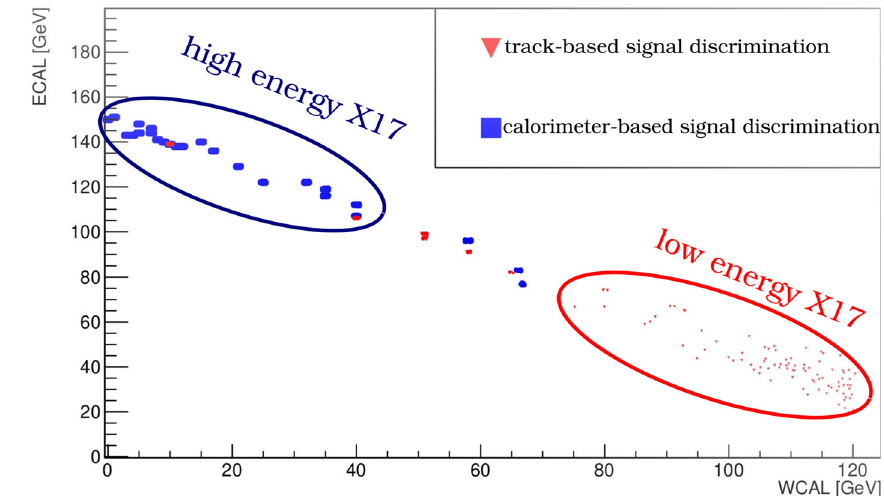
Table 1 N ne w / N old ratio between signal events observed in tracker- A (cid:4) A (cid:4) analysis compared to calorimeter-only analysis. The new analysis uses cuts based on GEM tracking detectors if the energy detected by the downstream ECAL is below 75